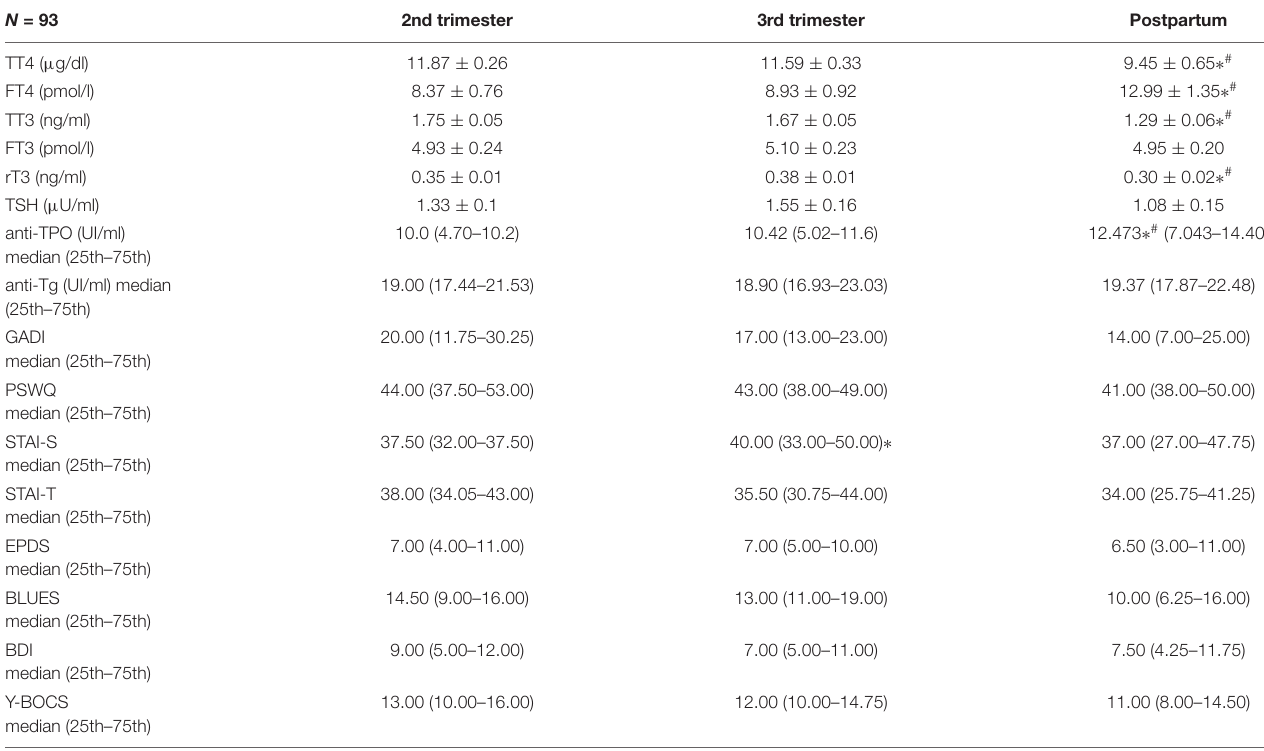
TABLE 1 | Hormonal and psychometric variables at pregnancy and